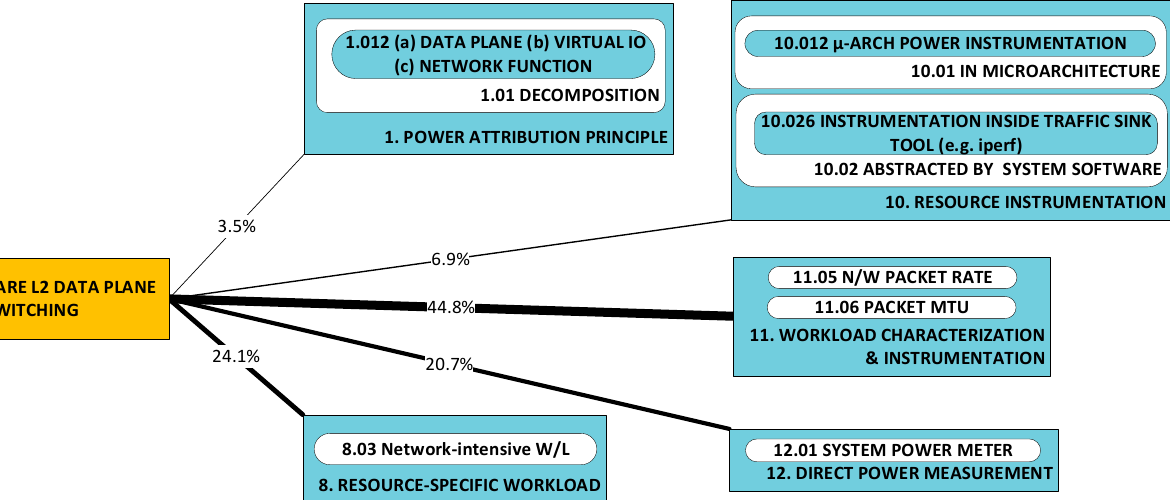
Figure 12. Approaches to solving challenges in category P11; utility metric U A thickness and as a percentage. RUs in the respective categories are the following: P11 [48,53]; A1 [48]; A8 [48,53]; A10 [48]; A11 [48,53]; A12 [48,53].